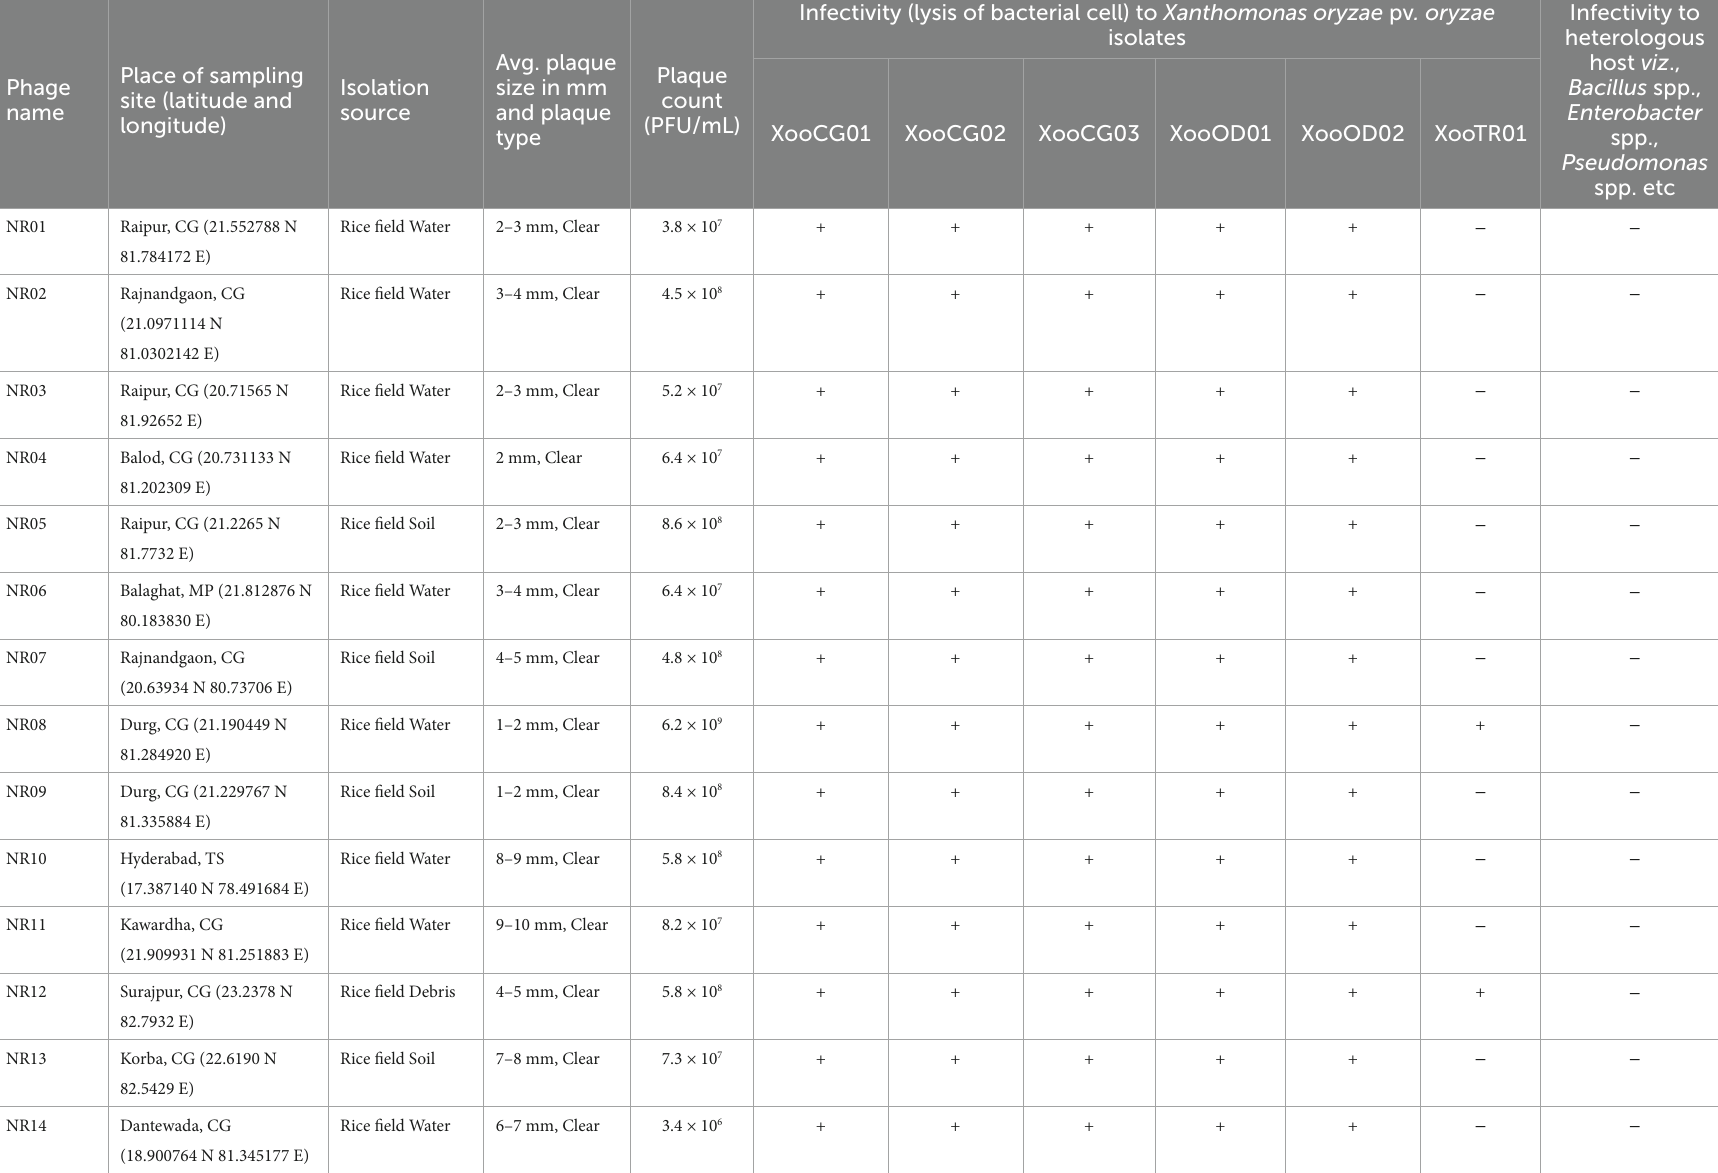
TABLE 1 Table showing the details of isolation source and sites, plaque size, and host range of 19 bacteriophages against Xanthomonas oryzae pv . oryzae.